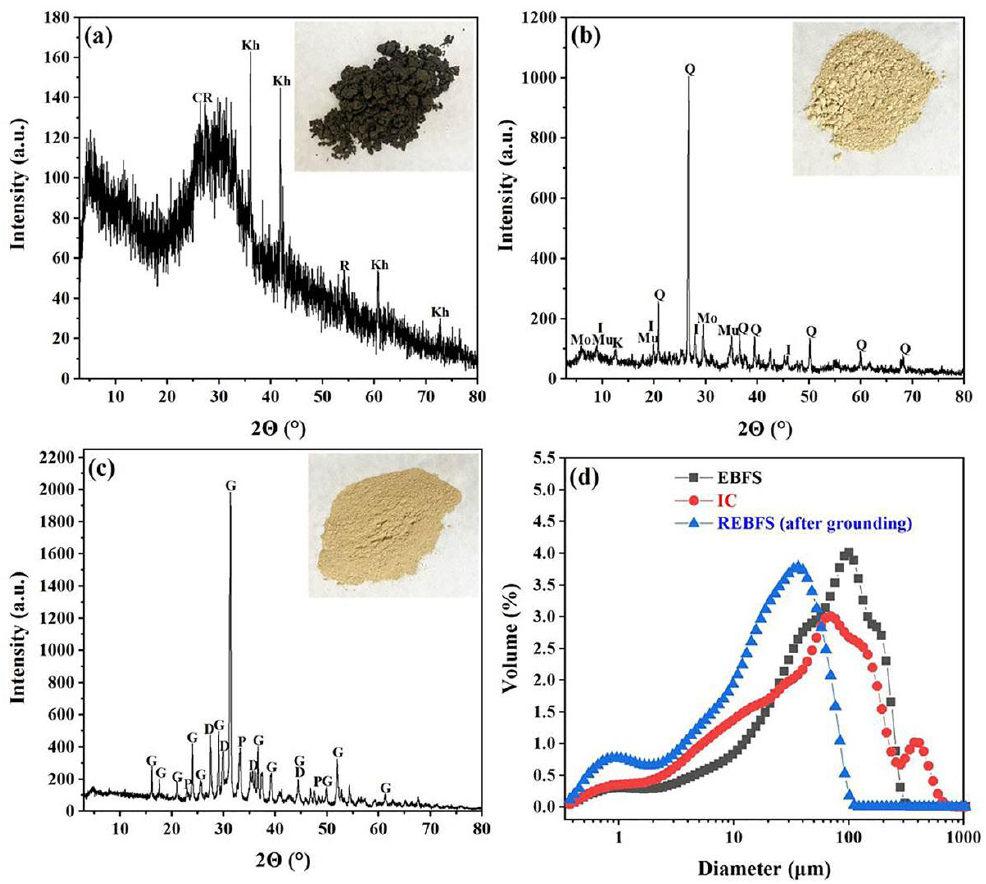
Figure 2. Phase compositions and particle properties of raw materials. ( a – c ) XRD patterns of EBFS, IC, and REBFS, respectively. ( d ) Particle size distribution. C = Carbon, Kh = Khamrabaevite, R = Rutile, G = Gehlenite, D = Diopside, P = Perovskite, Q = Quartz, I = Illite, Mo = Montmorillonite, Mu = Muscovite, K = Kaolinite.